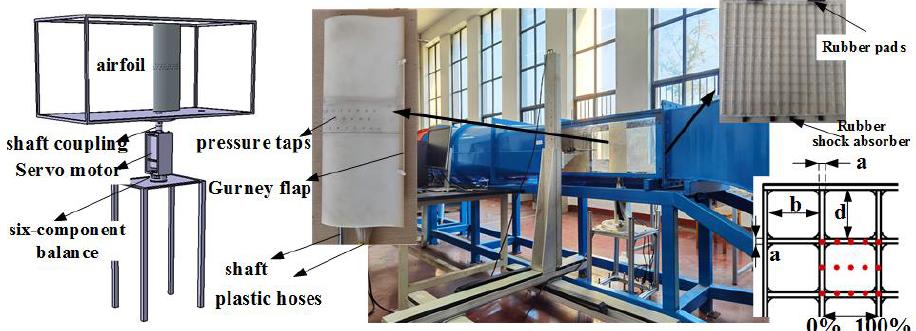
Figure 1. 3 D model of the test setup and pitching oscillation mechanism used in the test.